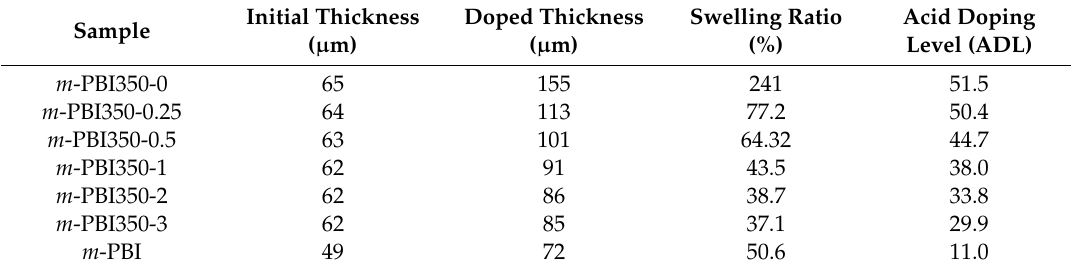
Table 1. Swelling ratio and PA doping level of m -PBI350-x membranes.